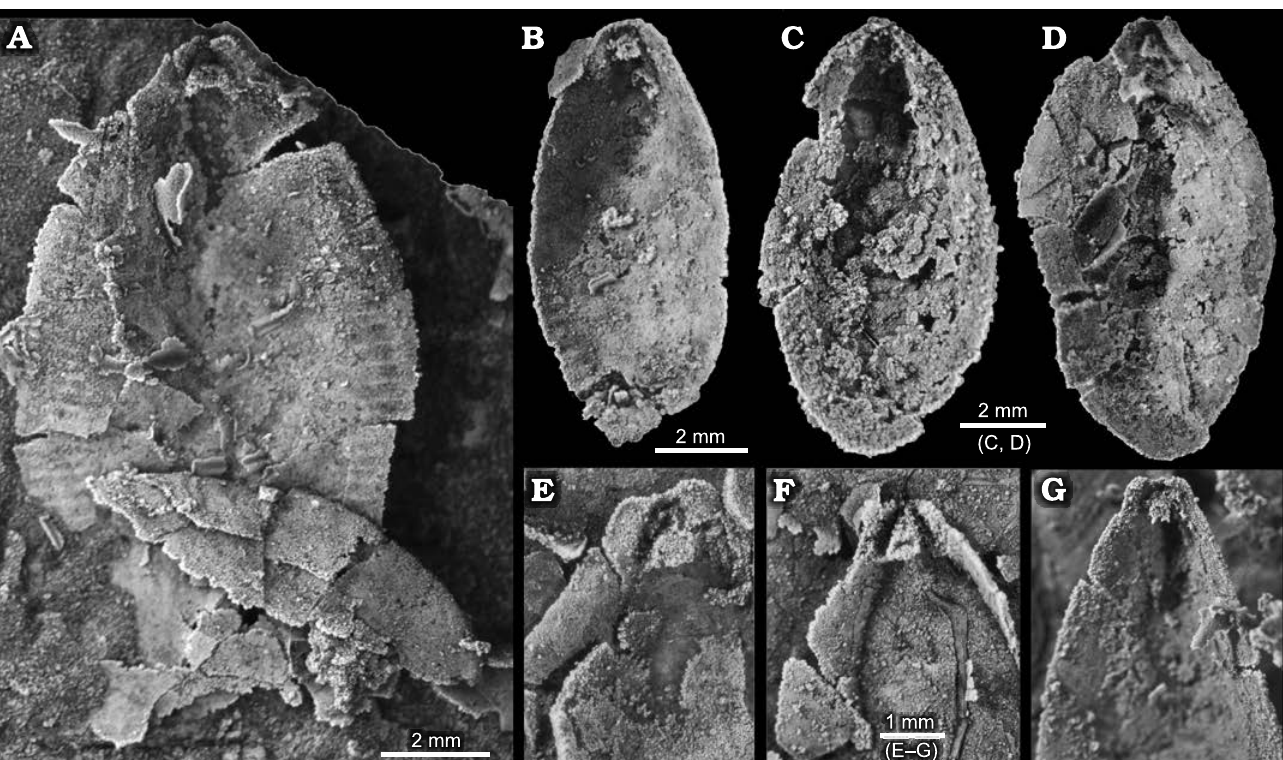
Fig. 8. Stenothecoid pan-brachiopod Stenothecoides elongata (Walcott, 1884), middle Cambrian, Drumian Stage stratotype, Drum Mountains, western Utah (USA), Locality 8 (Robison 1964), internal shell features. Dorsal vs. ventral valves uncertain. A , B . TMP 2021.022.0001 ( A ) and TMP 2021.022.0002 ( B ), valves preserving peripheral furrows; note in A a prominent cardinal sulcus. C . TMP 2021.022.0003, valve interior, showing a cardinal pseudosocket. D . TMP 2021.022.0004, valve interior, preserving a nearly symmetrical apical area and conspicuous posterior median opening. E – G . Variation of apical areas of valve interiors. TMP 2021.022.0005 ( E ), TMP 2021.022.0006 ( F ), TMP 2021.022.0007 ( G ).